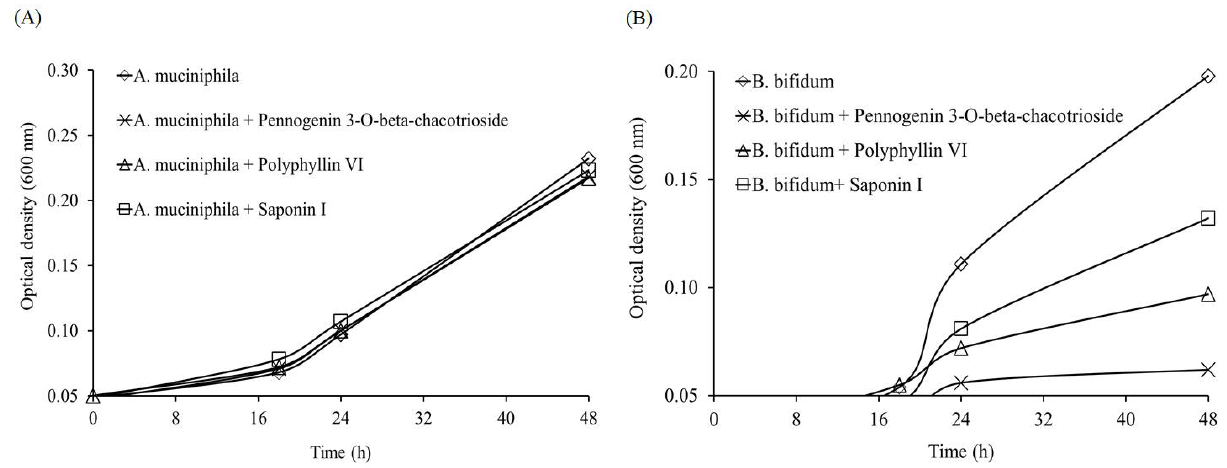
Figure 8. Cell migration capacity was determined by wound healing assay. Caco-2 cells were treated with F. nucleatum - derived EVs (1 × 10 8 particles/mL) for 36 h with or without pennogenin 3- O -beta-chacotrioside, polyphyllin VI, and saponin I at 1 μM. Cells were photographed after incubating for 36 h ( A ) and the area of the wound was quantified ( B ). Data are shown as means ± SD ( n = 3). Variables that are statistically different ( p < 0.05) are denoted by different letters.